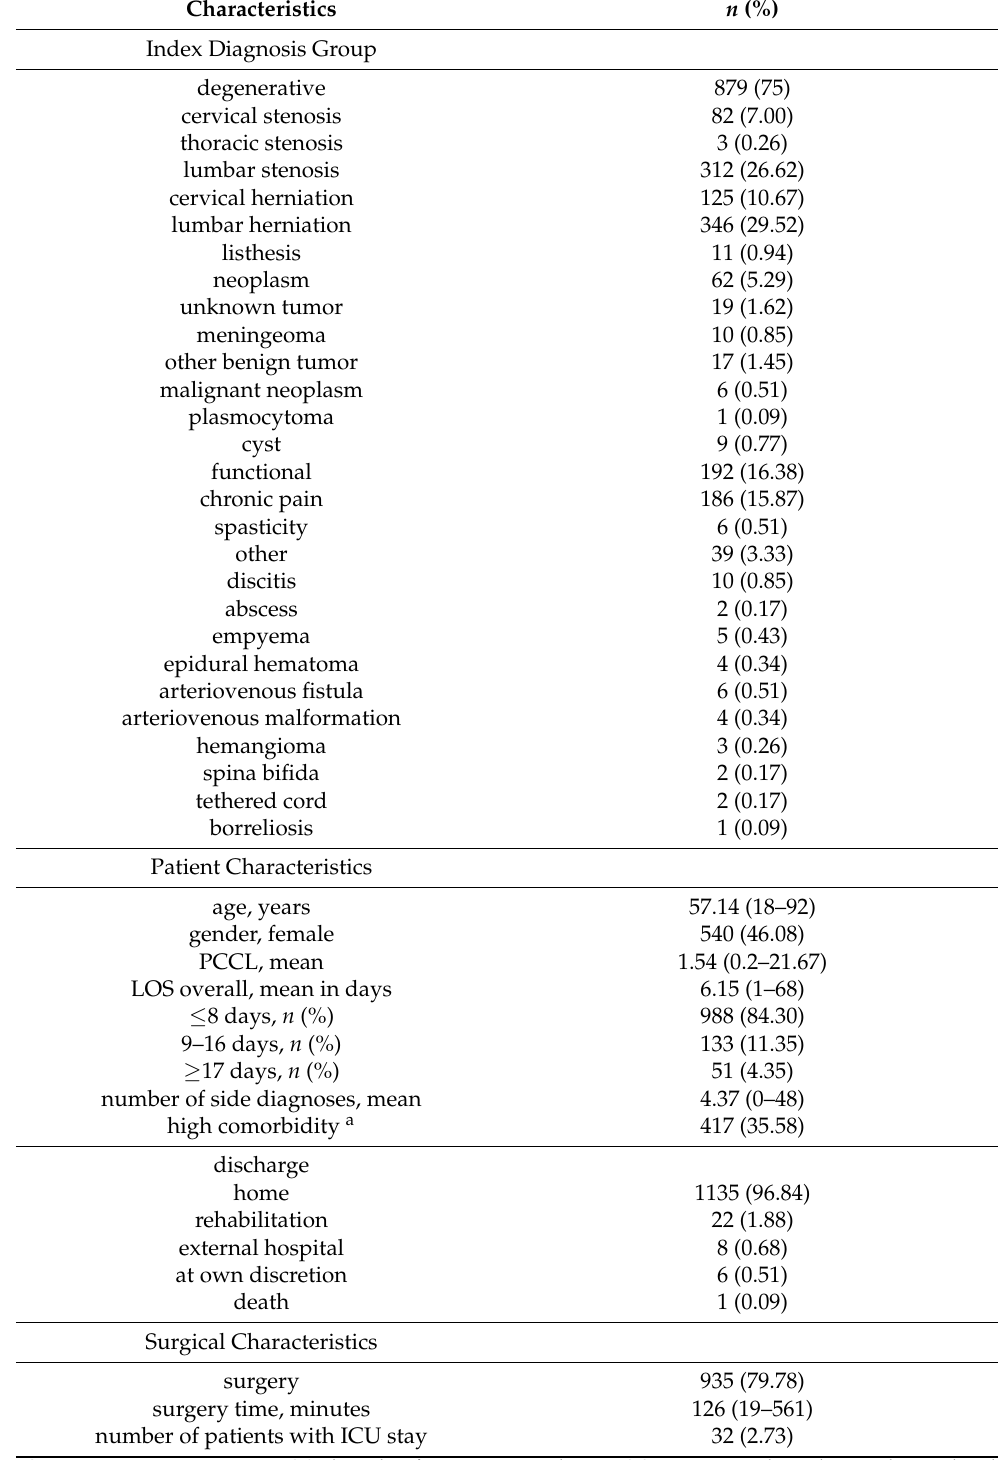
Table 1. Characteristics of the total